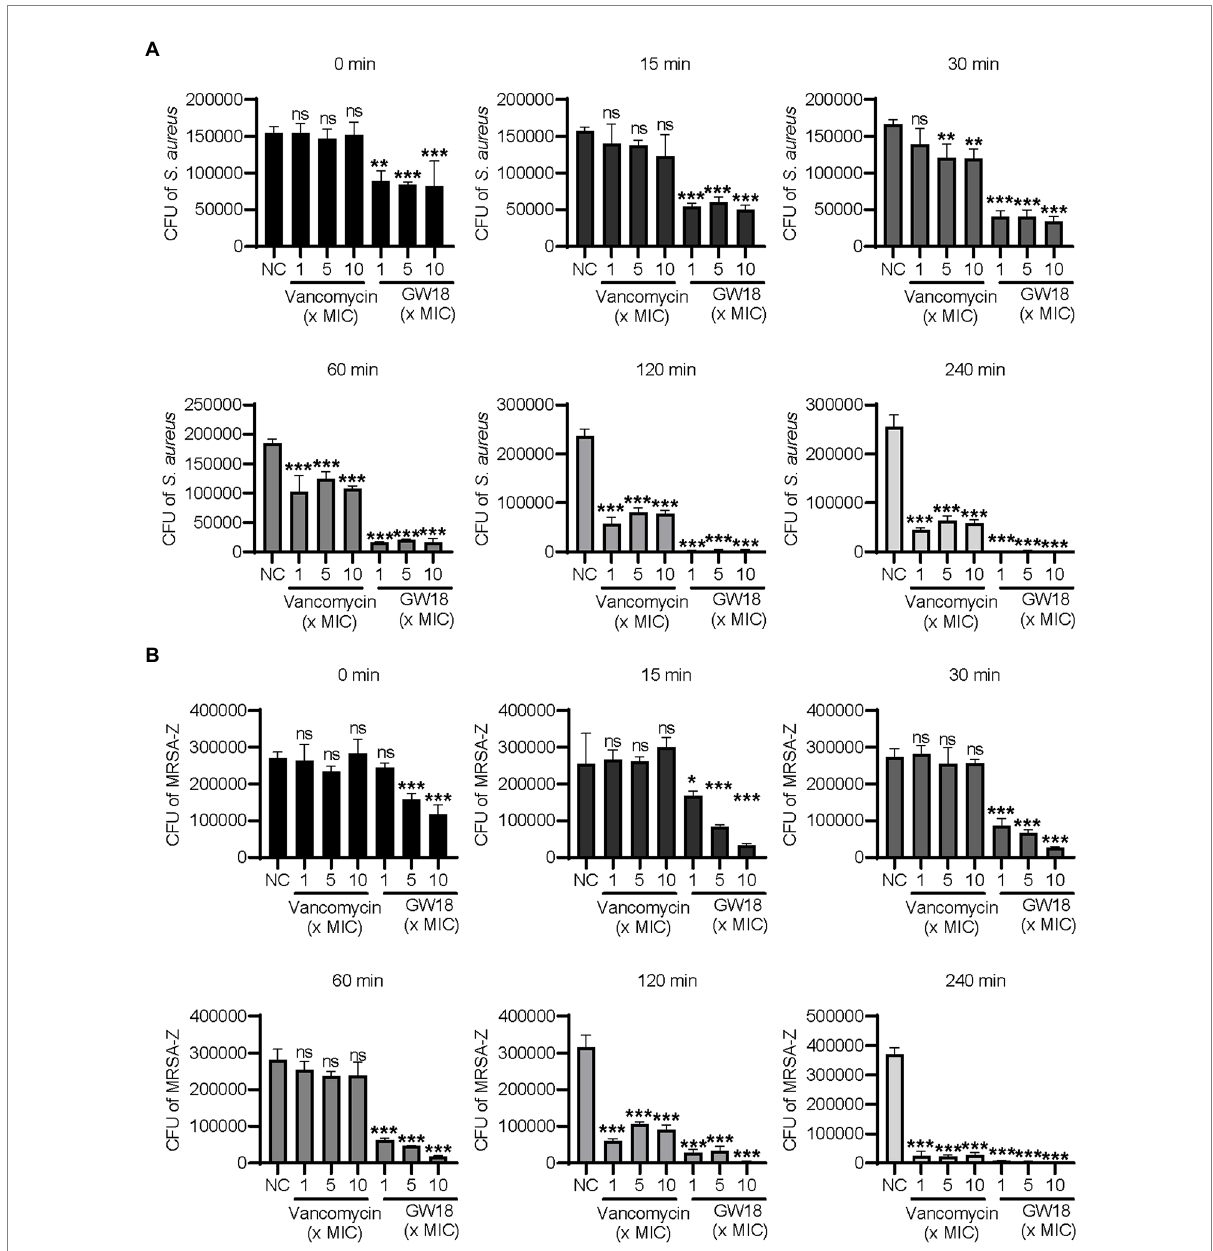
FIGURE 2 Killing kinetic of GW18 against S. aureus . S. aureus (ATCC6538, A) and methicillin-resistant S. aureus (MRSA-Z, B) were incubated with GW18 (1, 5, 10 × MIC) or vancomycin (1, 5, 10 × MIC) at 37 ° C for 0, 15, 30, 60, 120 and 240 min, respectively. Ten microliter aliquots were extracted at each time point and diluted with fresh broth for 100 times, 100 μl of the dilution was seeded on agar plates. After incubation at 37 ° C for 24 h, the viable colonies were determined for the killing kinetic analysis. Data represent mean ± SD values of three independent experiments. * p < 0.05, ** p < 0.01, *** p <